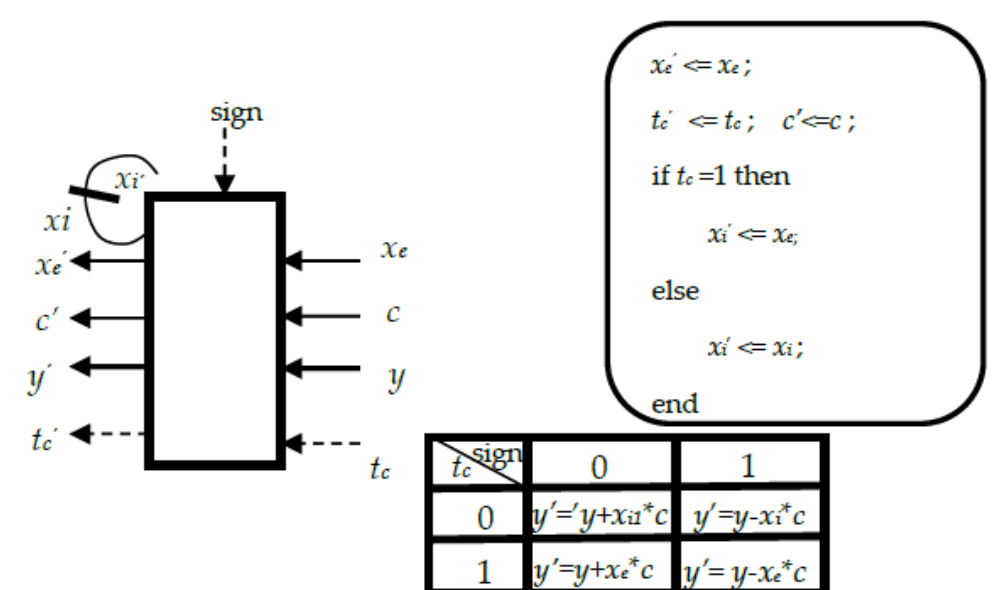
Figure 1. The function of the processing elements PE from Figures 2 – 5 [26].